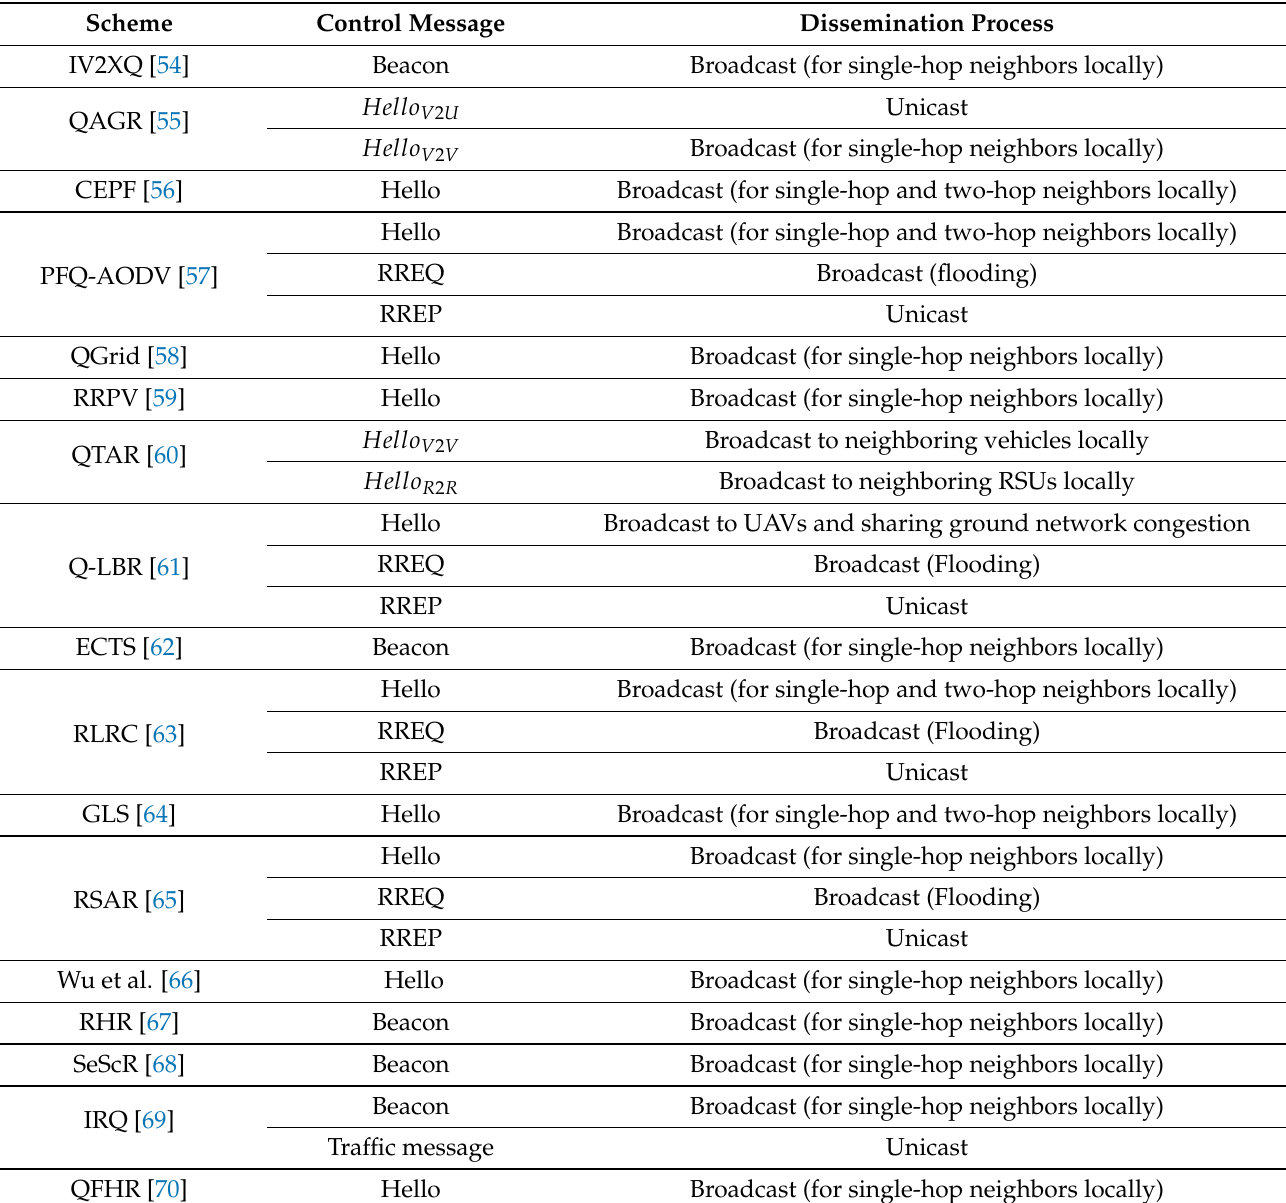
Table 11. Comparison of various routing methods in terms of control